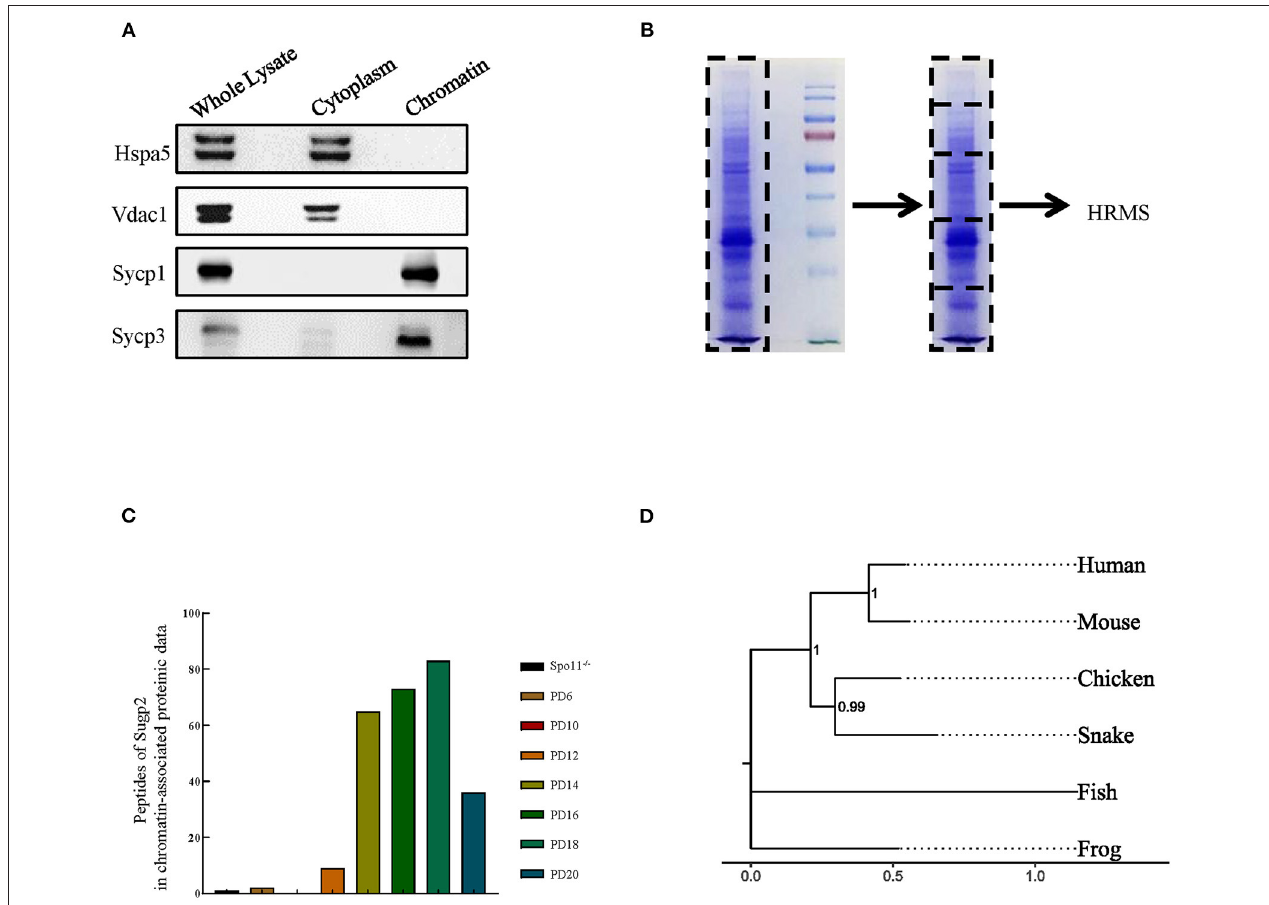
FIGURE 1 | Sugp2 was a putative spermatogenetic chromatin-associated protein by proteomic identification. (A) Purity assessment of isolated testis chromatin-associated proteins by western blot. Sycp1 and Sycp3 are components of meiotic synapsis complex and associated with chromatin. Hspa5 and Vdac1 are cytoplasmic protein controls. (B) Identification of chromatin-associated proteins by high-resolution mass spectrum. (C) Peptide counts of Sugp2 in testis from Spo11 knockout (Spo11 − / − ) and different postnatal groups. (D) Phylogenetic tree for Sugp2 protein estimated by neighbor joining method. The tree was constructed by MEGA. Each name at the terminus represents the species from which the protein